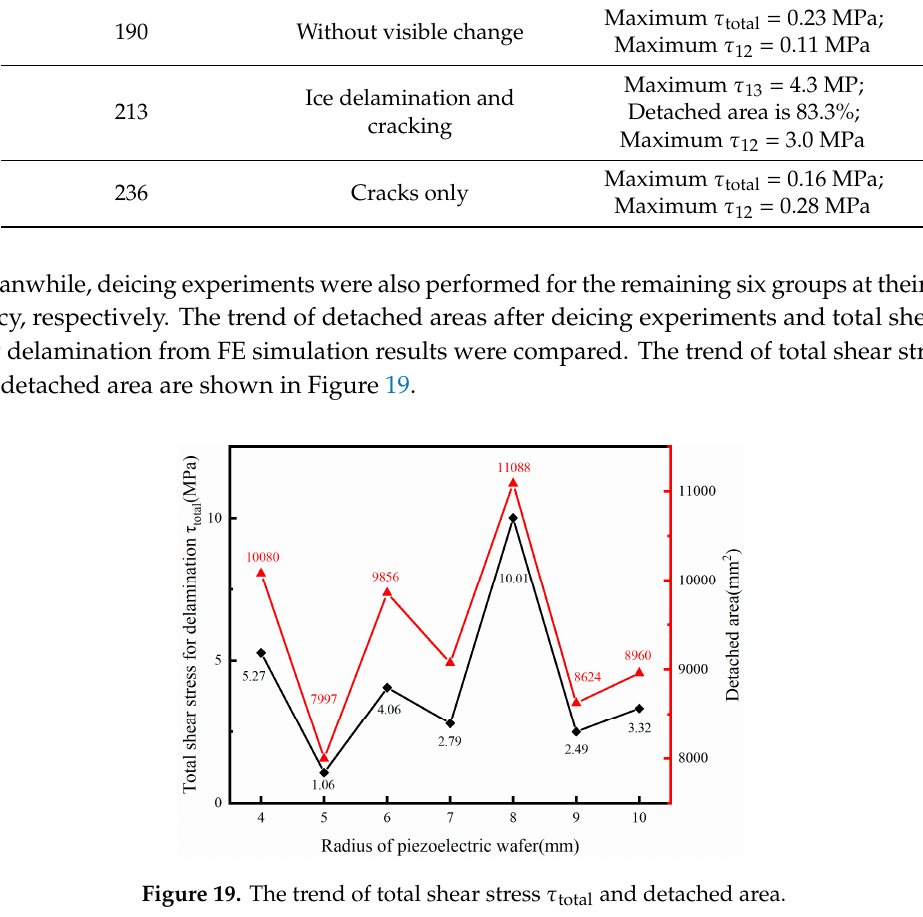
Figure 20. The trend of detached area and deicing efficiency factor (DEF) for four different icing cases.